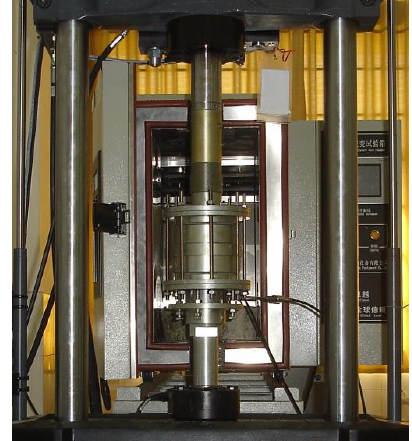
Figure 2. Schematic of triaxial test equipment.